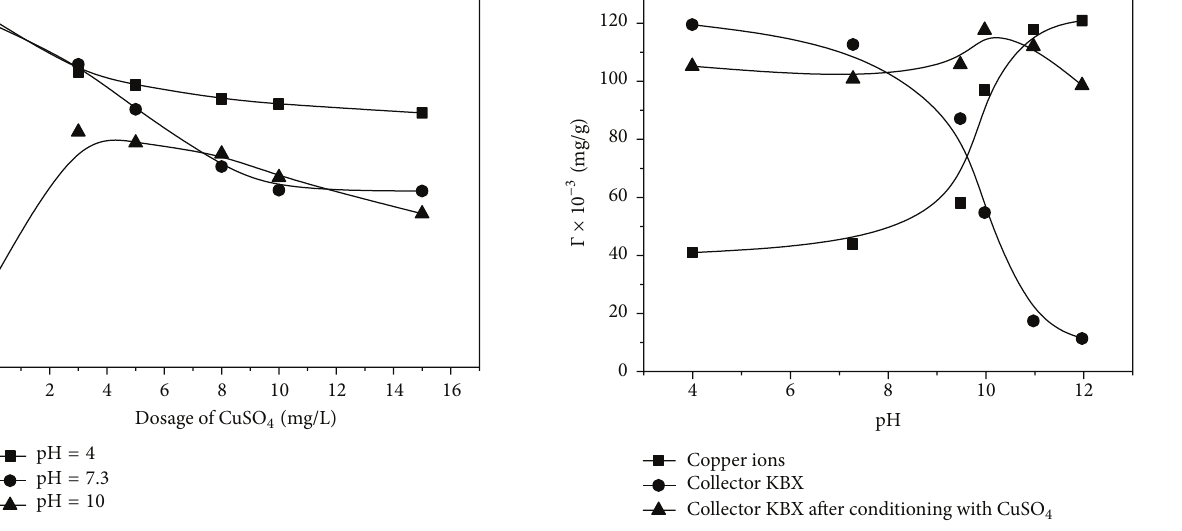
Figure 3: The adsorption amount of copper ions and KBX on the surface of